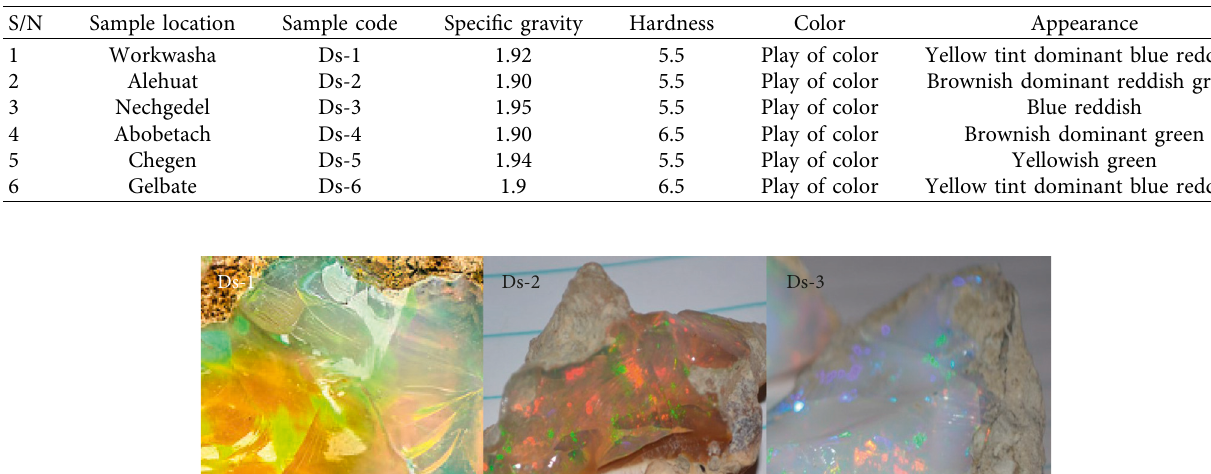
Table 1: Natural opal samples collected from different mining sites of Delanta district and description of their physical properties.